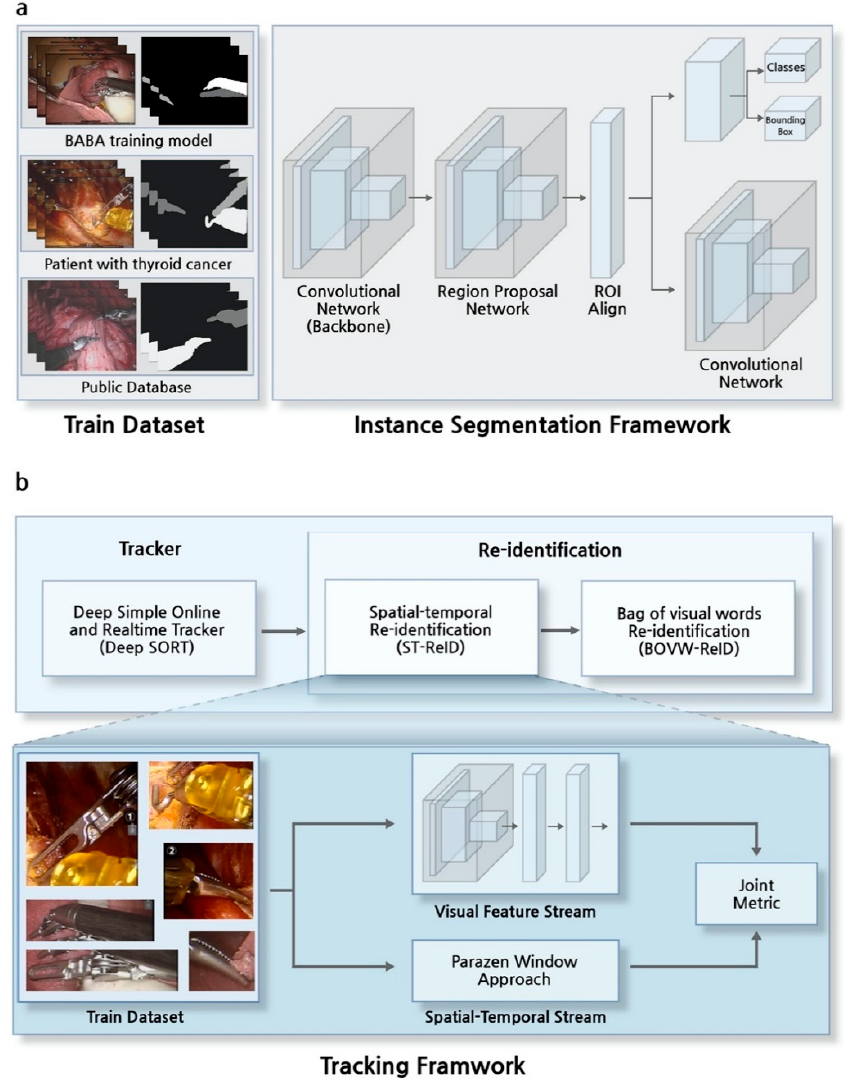
Figure 2. Overview of the instance segmentation and tracking frameworks. ( a ) The instance segmentation framework was trained with three types of training datasets: the bilateral axillo-breast approach (BABA) training model, patients, and a public database. ( b ) The tracking framework, consisting of a tracker and a sequence of re-identification algorithms. Spatial-temporal re-identification (ST-ReID) was trained with bounding boxes of all types of surgical instruments. Bag of visual words re-identification (BOVW-ReID) was applied after ST-ReID.